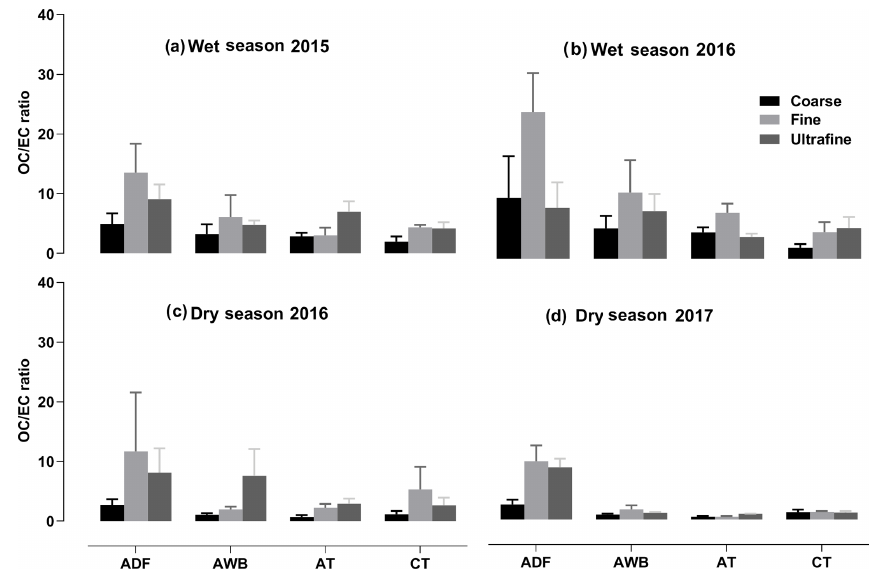
Figure 10. OC / EC ratio for the different campaigns and sites for each aerosol size (C in black, fine in light grey, ultrafine in grey). Each box shows the median and the first and the third quartiles.